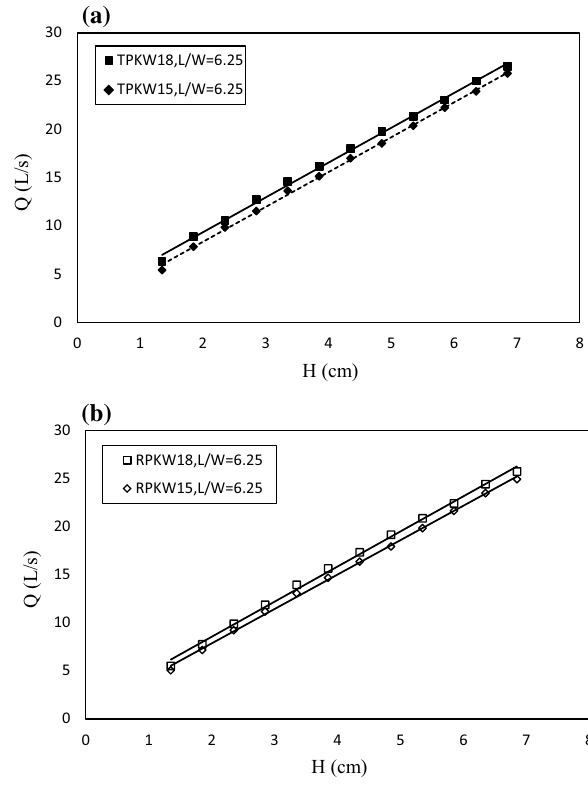
Fig. 6 Variation of discharge ( Q ) with head ( H ) showing the impact of height ( P ) of a trapezoidal, and b rectangular PK weirs